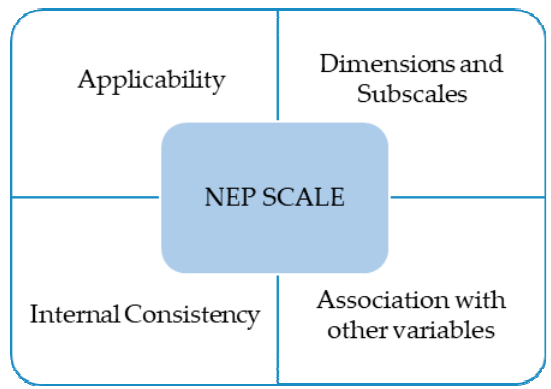
Figure 1. Main aspects of the literature review section concerning the New Environmental Paradigm (NEP) Scale.